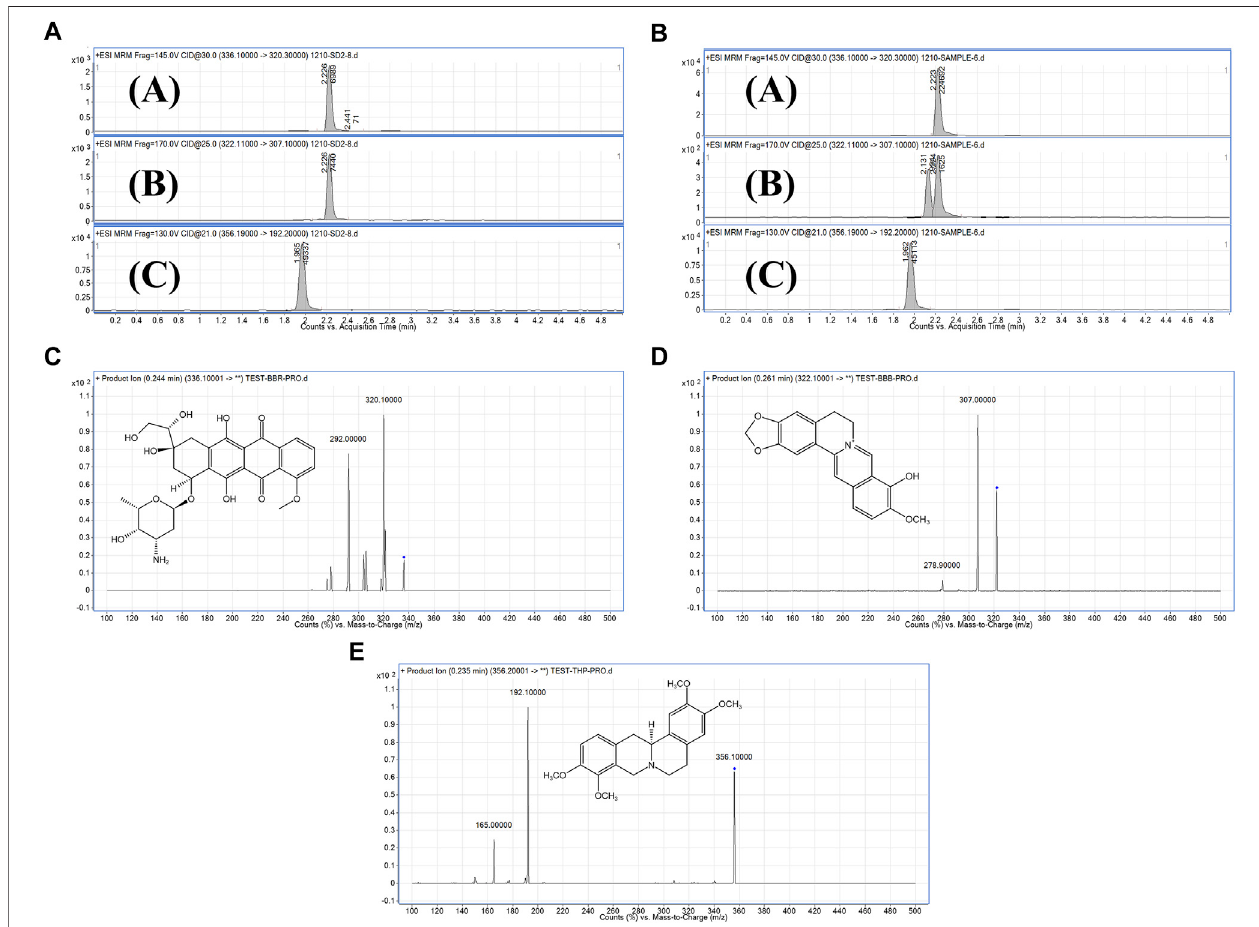
FIGURE 4 | MRM chromatograms and secondary mass spectrometry chromatograms. (A) . Standard substance MRM chromatograms of (A) BBR, (B) BBB, and (C) IS. (B) . Sample MRM chromatograms of (A) BBR, (B) BBB, and (C) IS. (C) . Secondary mass spectrometry chromatograms of BBR. (D) . Secondary